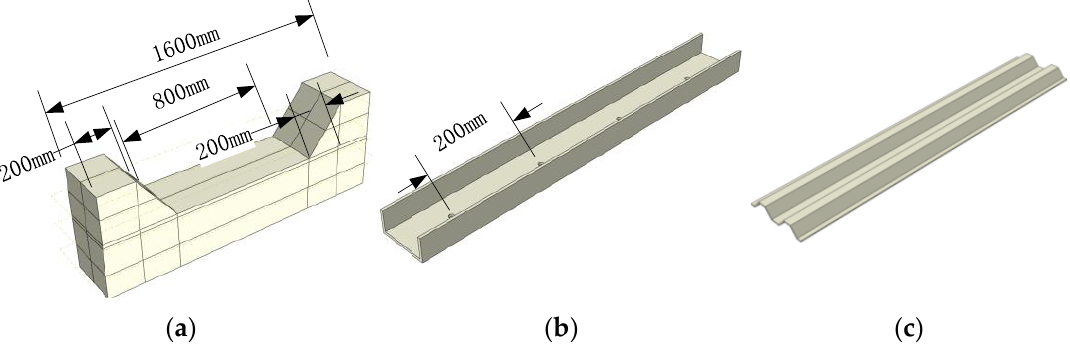
Figure 13. Numerical model. ( a ) Main part of bias column; ( b ) Channel steel; ( c ) Corrugated Steel Sheets.